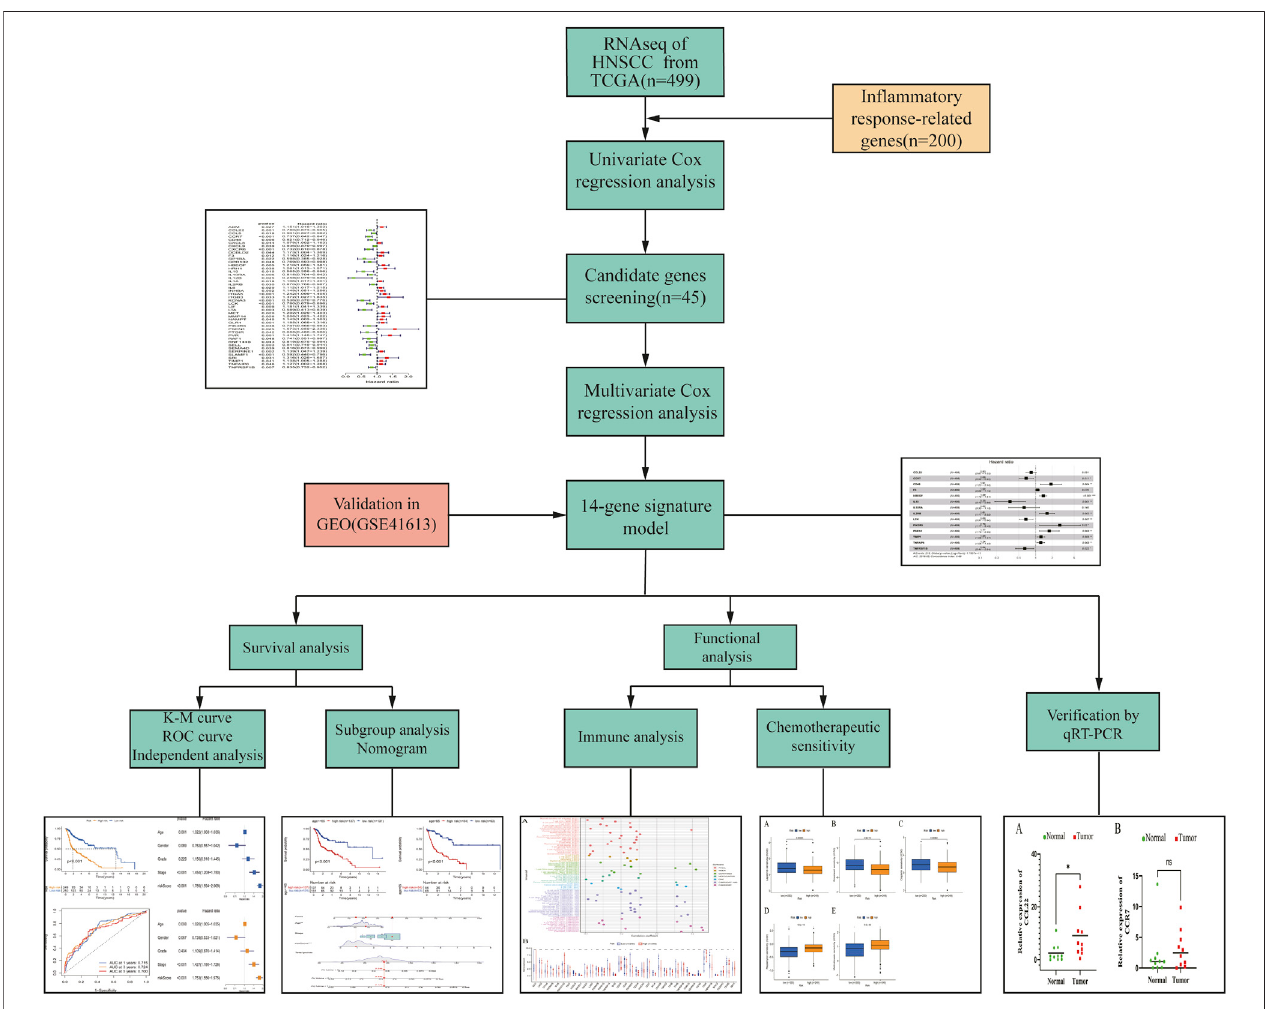
FIGURE 1 | Flow chart of the